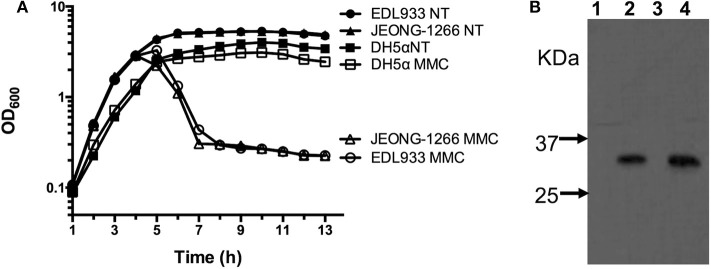
Analyses of Shiga toxin production. (A) Survival curve of JEONG-1266, as well as EDL933 and DH5α, with (MMC) and without (NT) mitomycin C treatment. Mitomycin C was added to bacterial cell cultures when the OD600 reached 0.7. (B) Western blotting to detect the expression of Shiga toxin 2 in JEONG-1266 with and without mitomycin C treatment. EDL933 was used as a positive control. Samples from Lane 1 to 4 were EDL933 without MMC (lane 1), EDL933 with MMC (lane 2), JEONG-1266 without MMC (lane 3), and JEONG-1266 with MMC (lane 4).